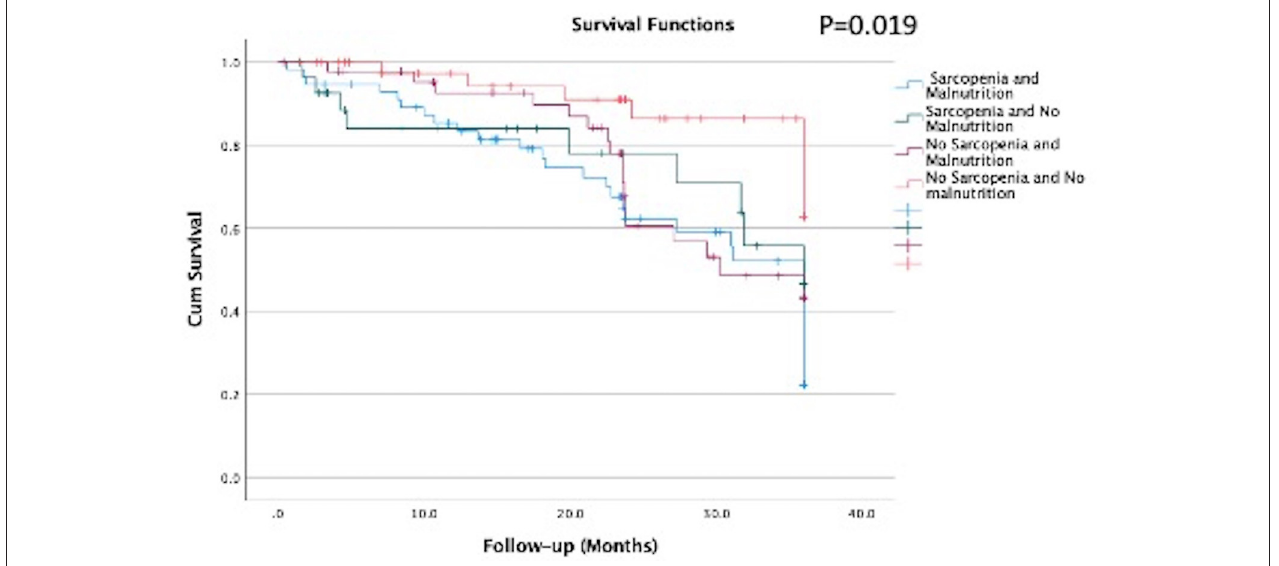
FIGURE 2 | Survival curves according to the groups with sarcopenia and malnutrition of elderly patients on hemodialysis ( n = 170).